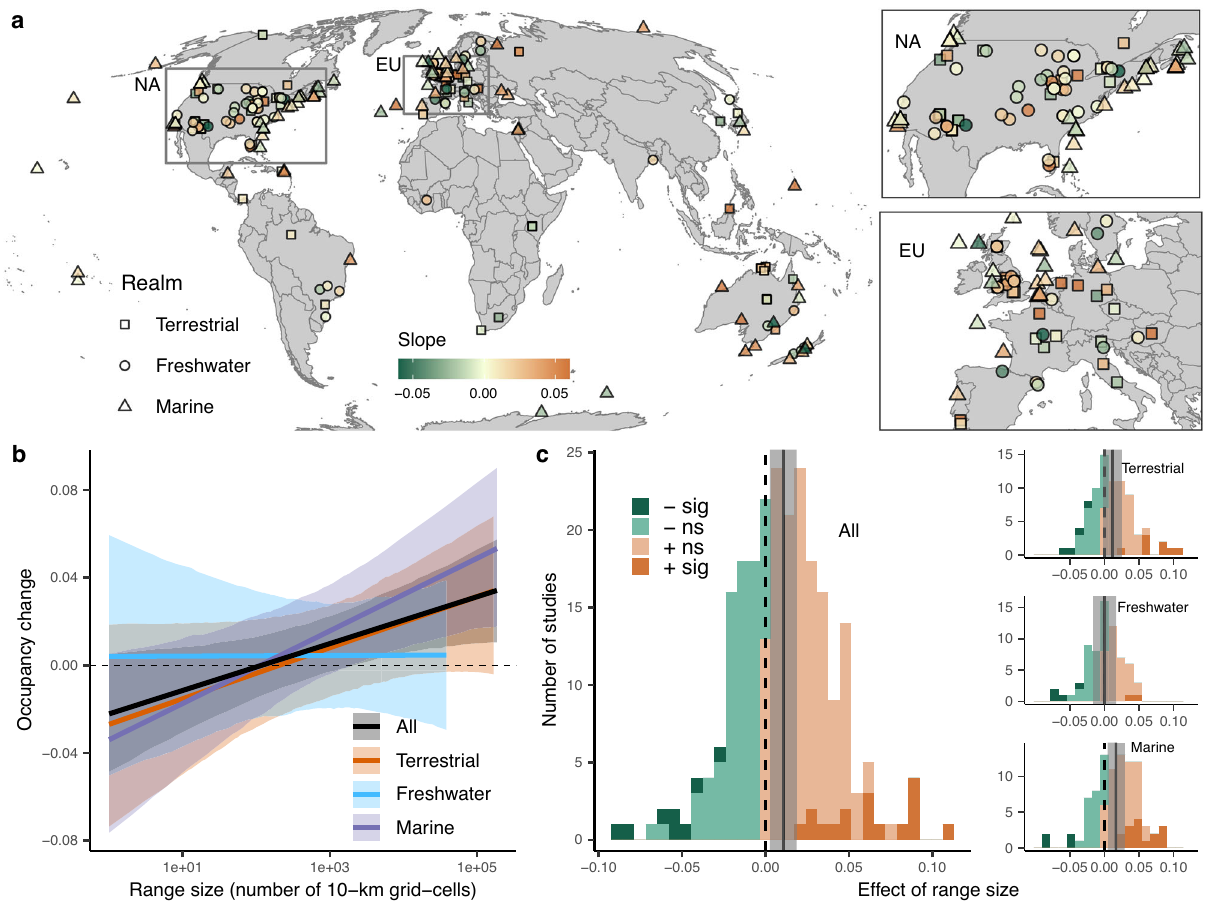
Fig. 2 | Small-ranged species lose, but large-ranged species gain occupancy overtime.a Globalmapshowingthedistributionofeffectsofrangesize(slope)on occupancychange of 238 studies in terrestrial ( n =81, squares),freshwater ( n =68, circles)andmarine( n =89,triangles)realms.InsertsshowdetailforNorthAmerica (NA) and Europe (EU). For clear visualization, the slopes smaller than − 0.06 or greaterthan0.06wereroundedto − 0.06or0.06. b Changesinspecies occupancy as a function of species ’ range sizes. Occupancy changes are the difference in occupancy between the late and early periods, shown as the square root- trans- formed for the absolute magnitude. The black line and shading show the overall positive relationship and 95% credible interval; colored lines and shading indicate